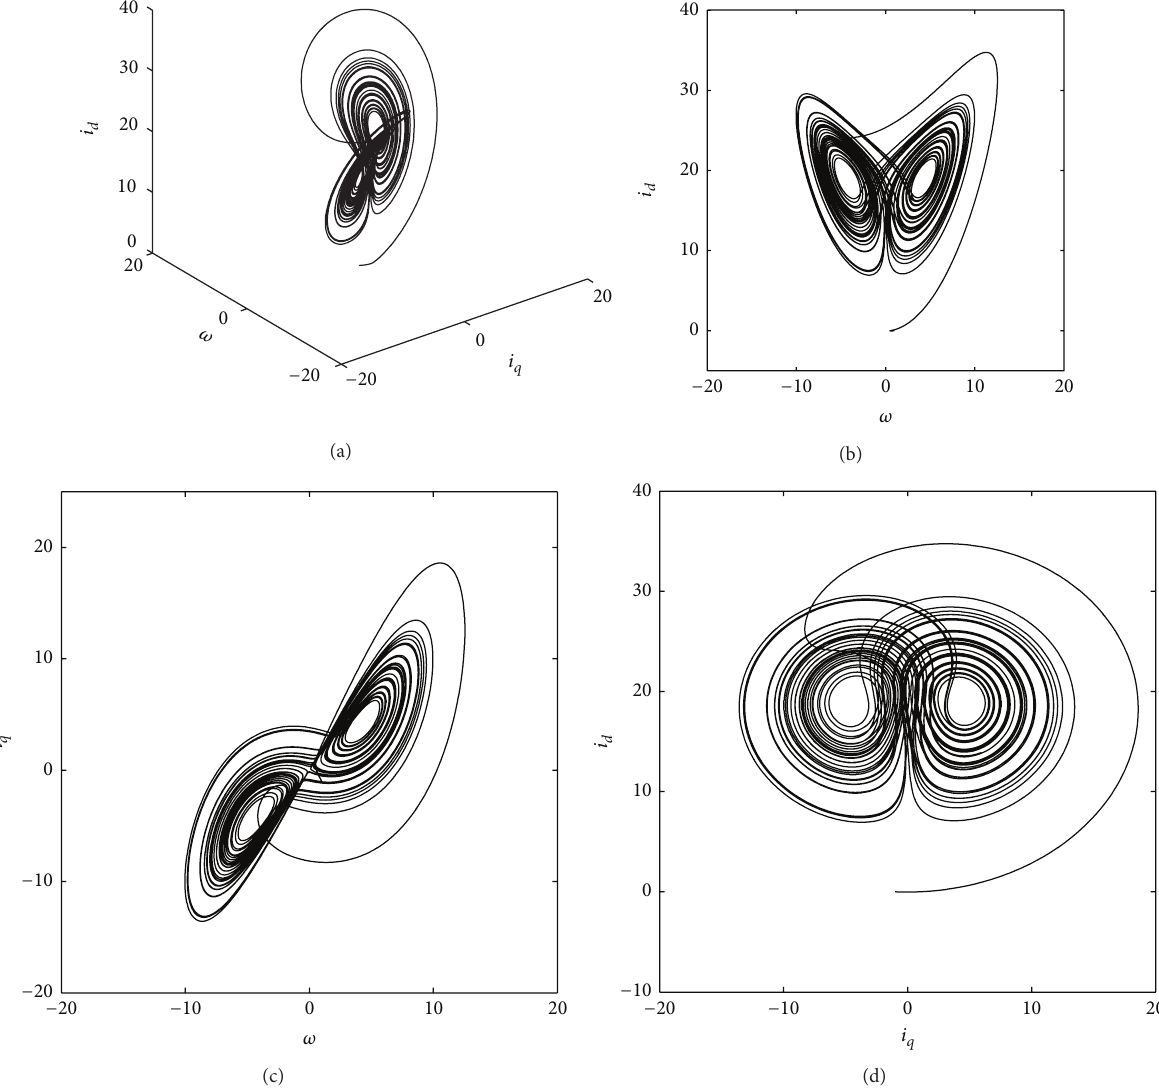
Figure 1: (a) Typical chaotic attractor in a PMSM. (b) Chaotic motion on 𝜔 - 𝑖 𝑑 plane. (c) Chaotic motion on 𝜔 - 𝑖 𝑞 plane. (d) Chaotic motion on 𝑖 𝑞 - 𝑖 𝑑